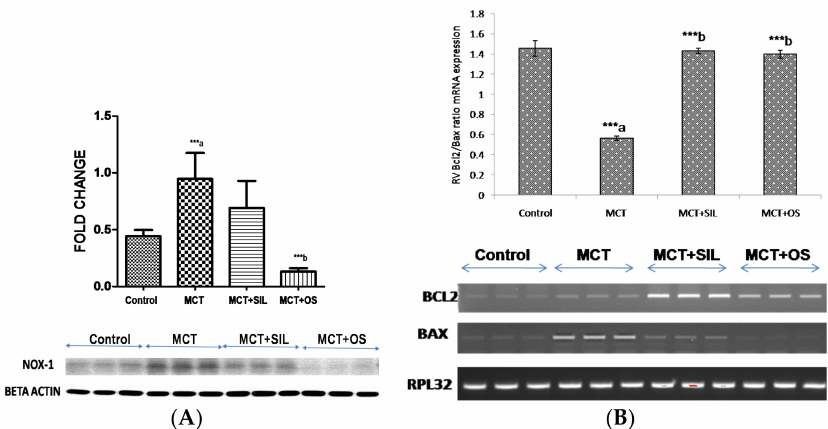
Figure 5. Effect of OS on ( A ) lung Nox-1 protein expression in MCT-induced PH; ( B ) heart mRNA expression of Bcl2/Bax ratio. *** p < 0.001; a—as compared to control, b—as compared to MCT. *** p < 0.001; a—as compared to control, b—as compared to